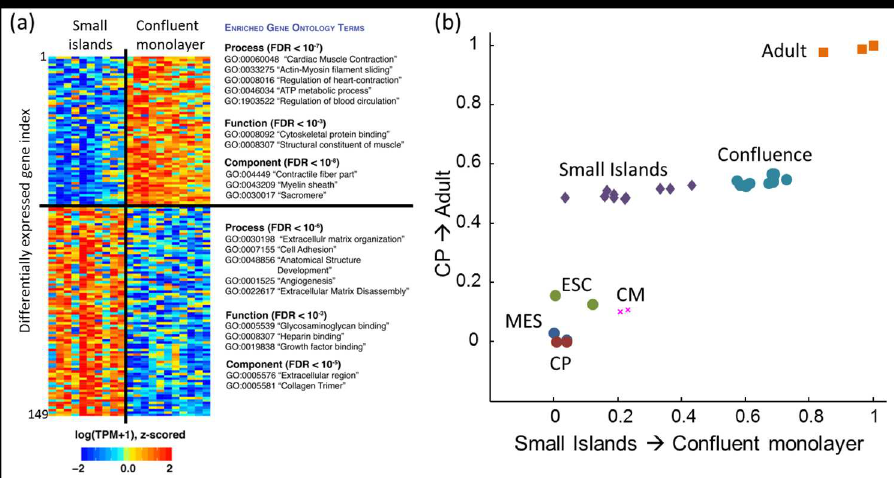
Fig 4. RNA sequencing to probe the difference between hiPSC-CM grown in small (100 μ m) islands vs. a confluent monolayer. a) Confluent cells had greater expression of cardiac-related genes, while cells grown on small islands had greater expression of genes related to extracellular matrix, adhesion, and angiogenesis. b) Gene expression differences between small islands and confluent monolayer, projected onto two vectors in gene-expression space. The CP ! Adult axis comprises the 3,463 genes that were significantly differentially expressed between cardiac progenitors and adult cardiomyocytes. The Small Islands ! Confluent monolayer axis comprises the 149 genes that were significantly differentially expressed between the two island sizes. ESC: embryonic stem cells MES: mesoderm, CP: cardiac progenitors, CM: embryonic stem cell-derived